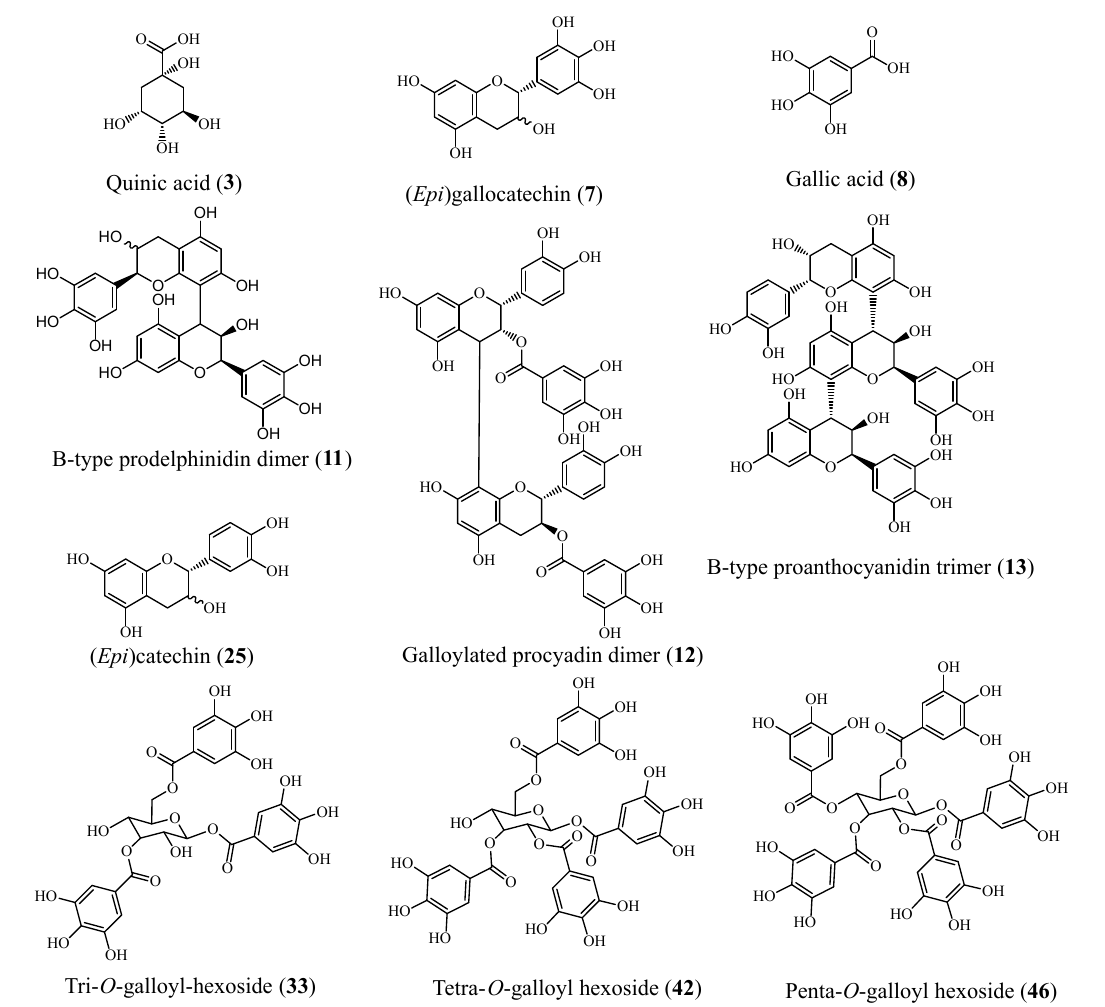
Figure 3. ( A ) UPLC-ESI-MS base peak chromatogram of P. racemosa leaves methanol extract (PRL- Me) in the negative ion mode. ( B ) UPLC-ESI-MS base peak chromatogram of P. racemosa stem meth- anol extract (PRS-ME) in the negative ion mode. Peaks are numbered relative to compounds listed in Table 2.